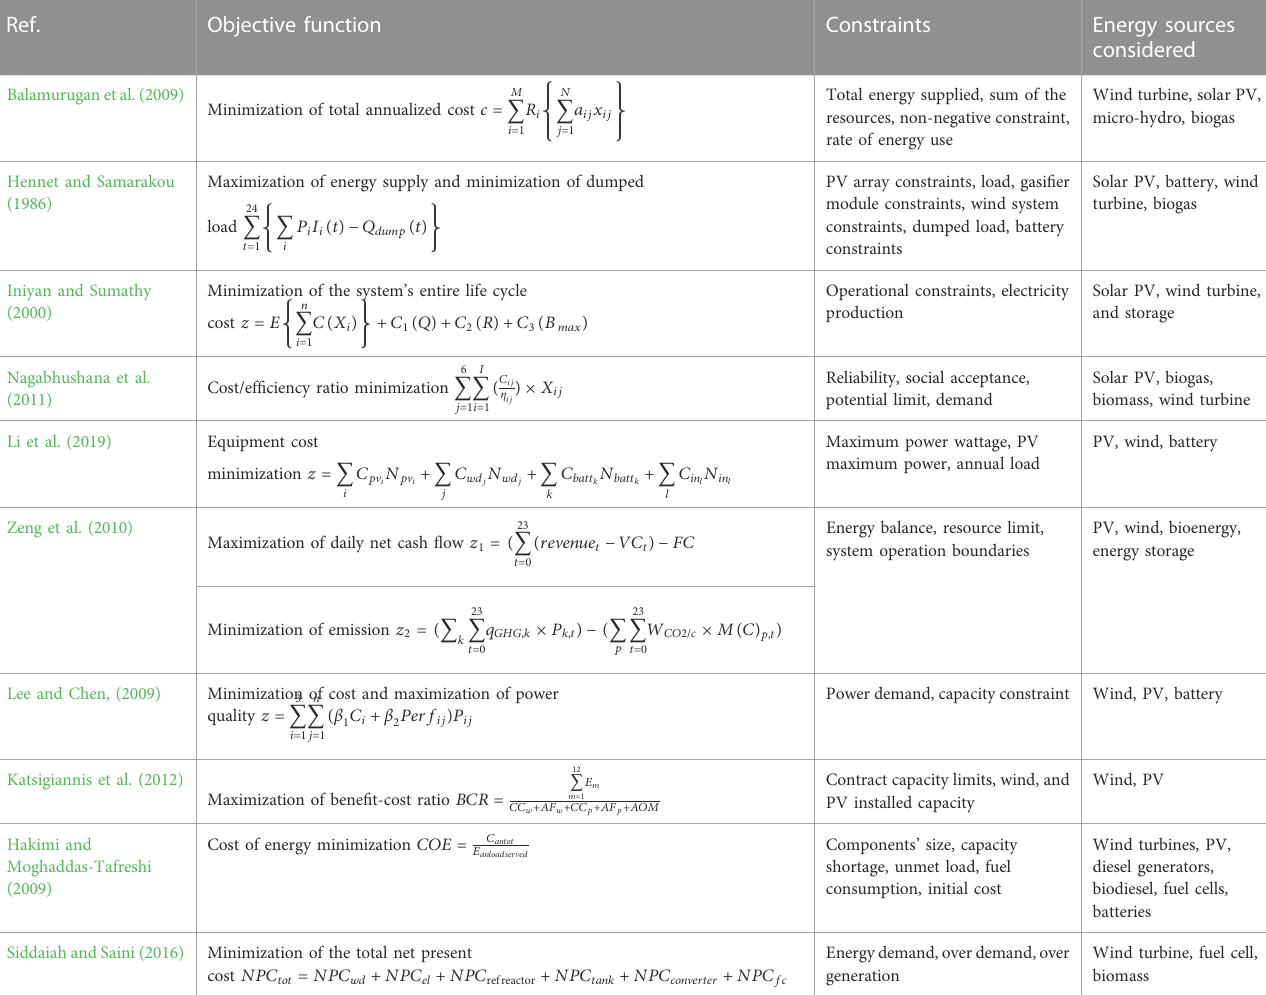
TABLE 4 Objective functions in the implementation of mini-grids.